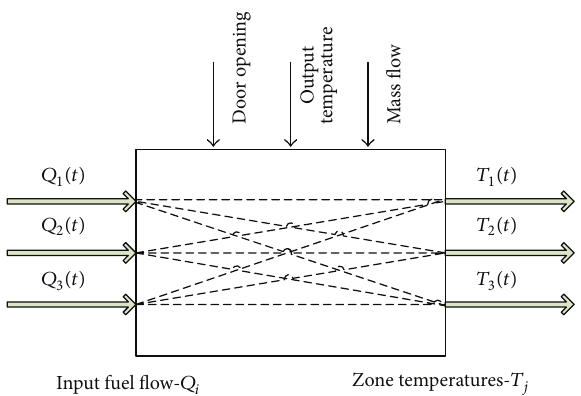
Figure 1: Diagram of the conceptual MIMO system model for gas- fired furnace in FZC “11